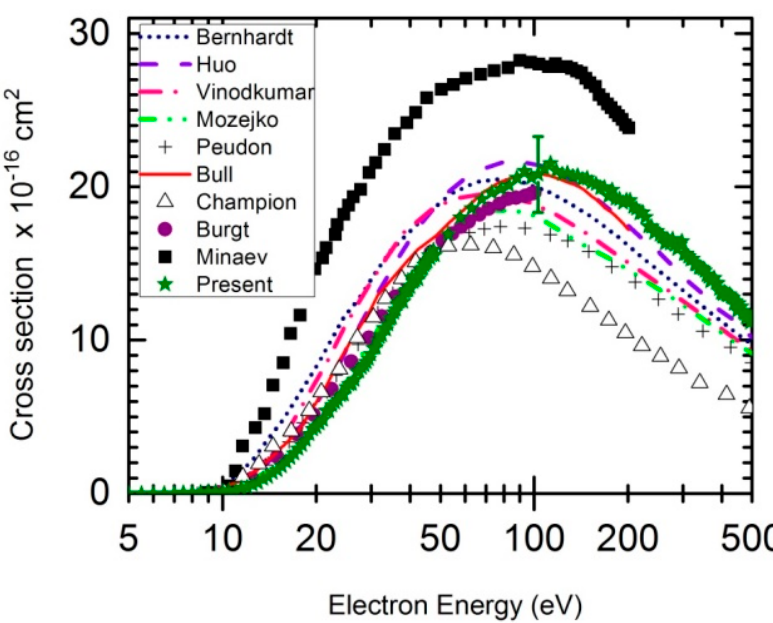
Figure 5. Total ionization cross section for the adenine molecule and its comparison with the existing data (Reproduced from Ref. [40]).